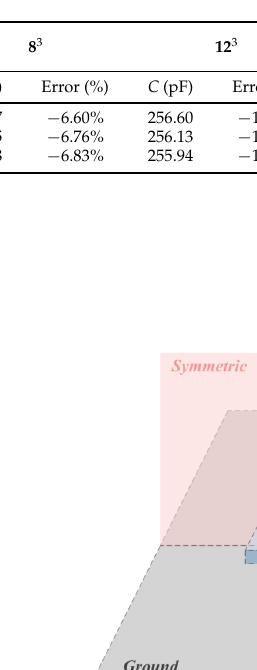
Table 3. Capacitance comparison with different mesh densities and electrostatic fields for the